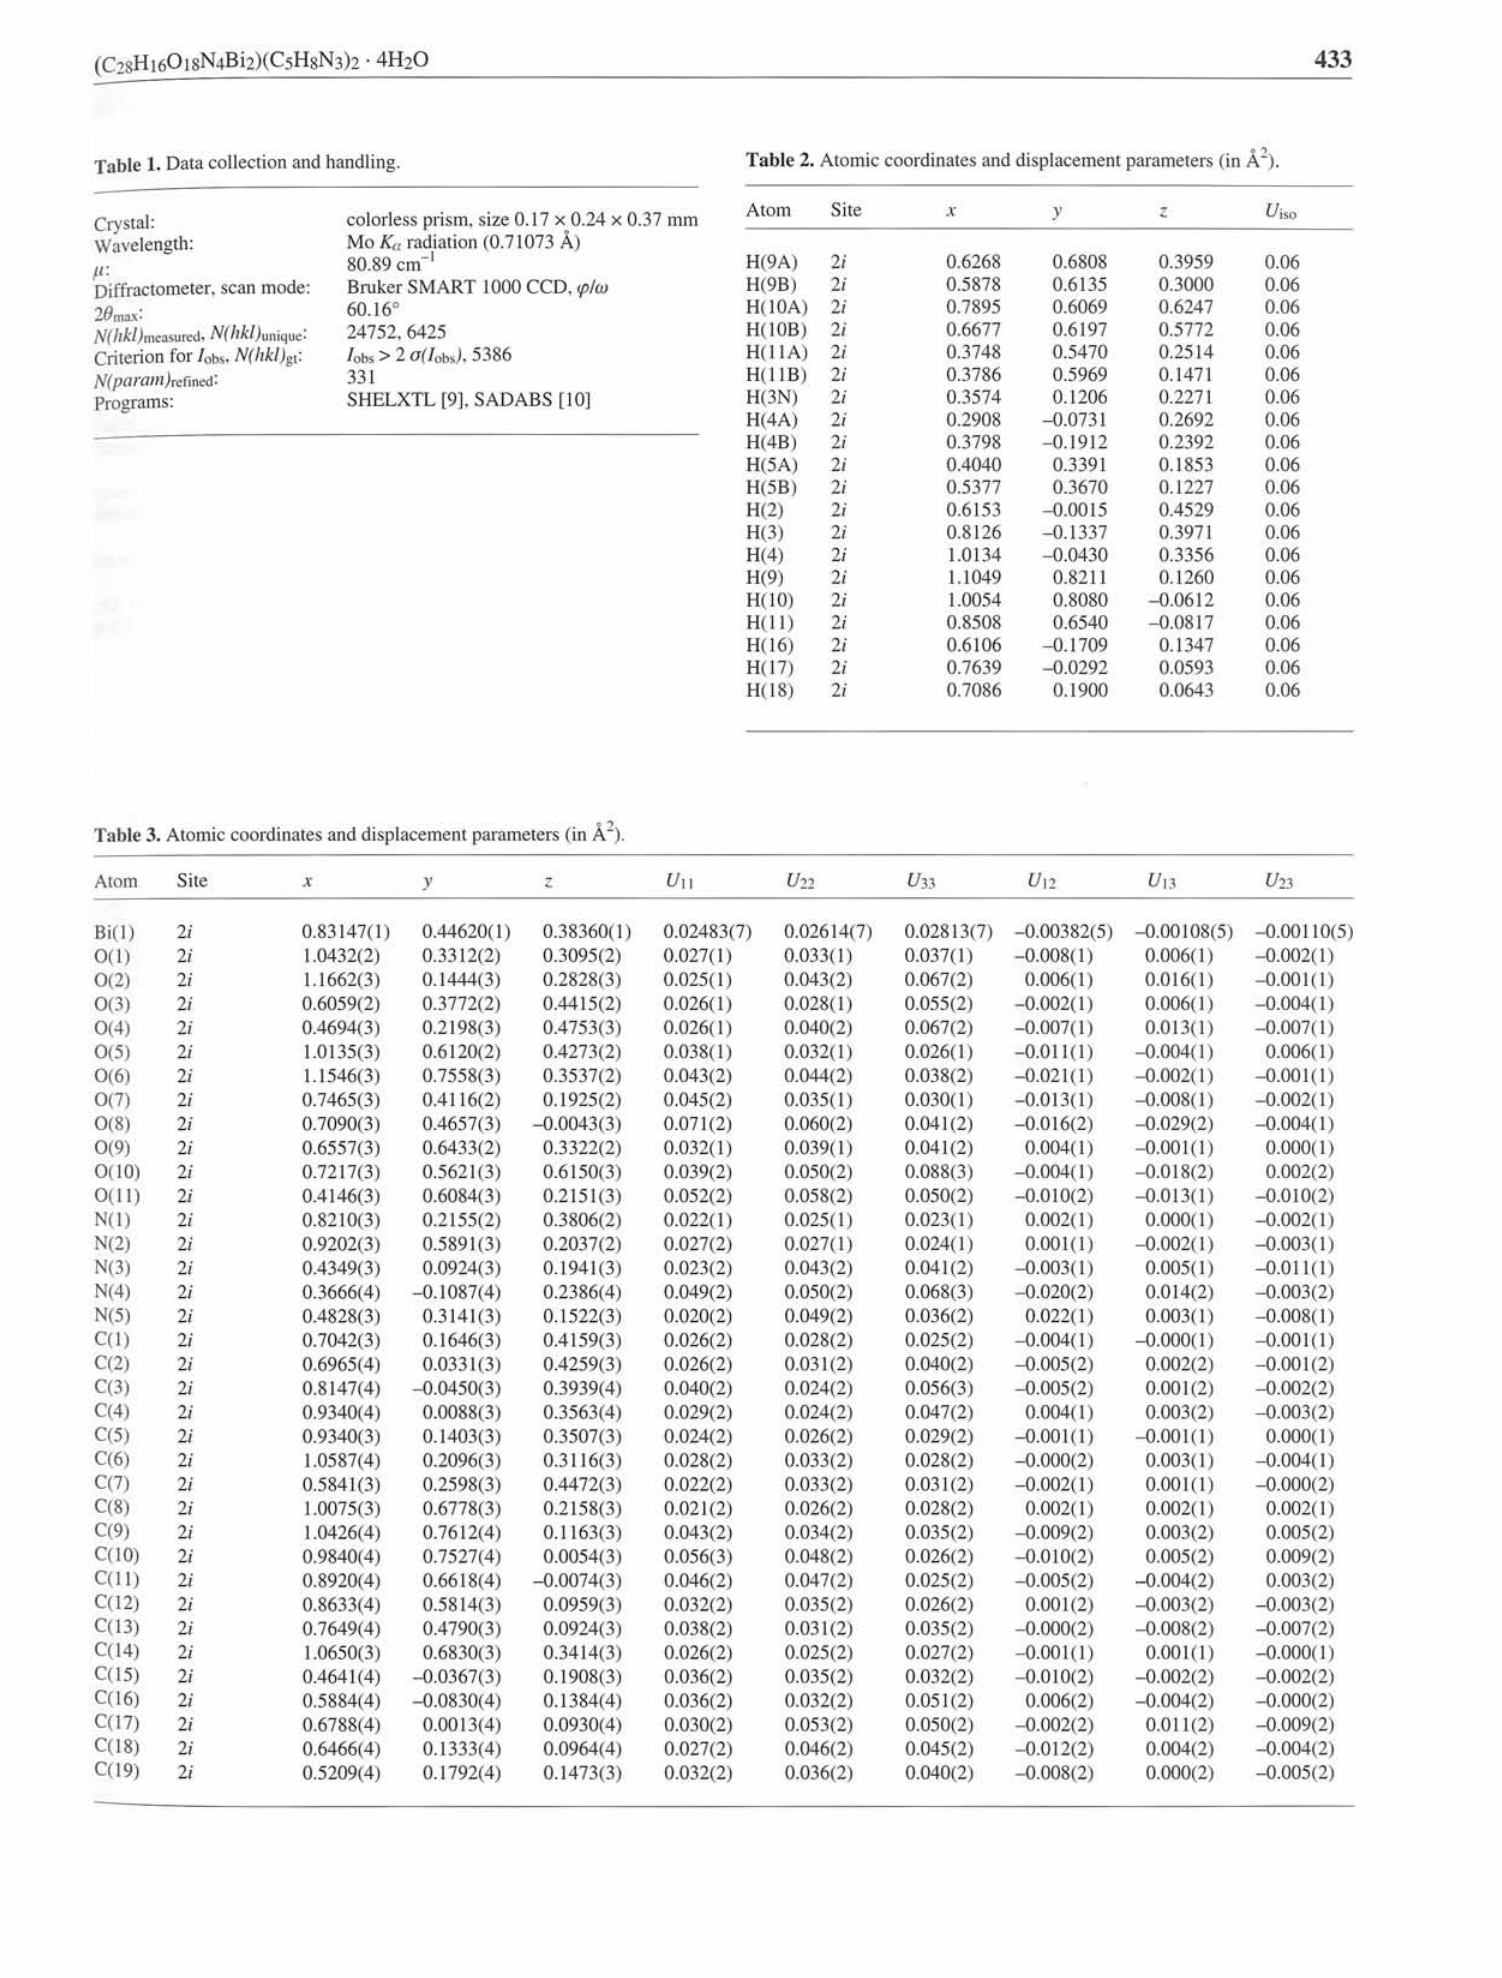
Table 3. Atomic coordinates and displacement parameters (in Â